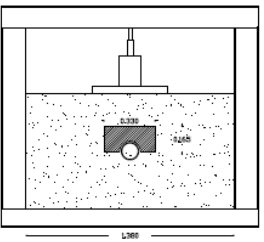
Figure 4. The experimental set pipe encased with embedded EPS block model